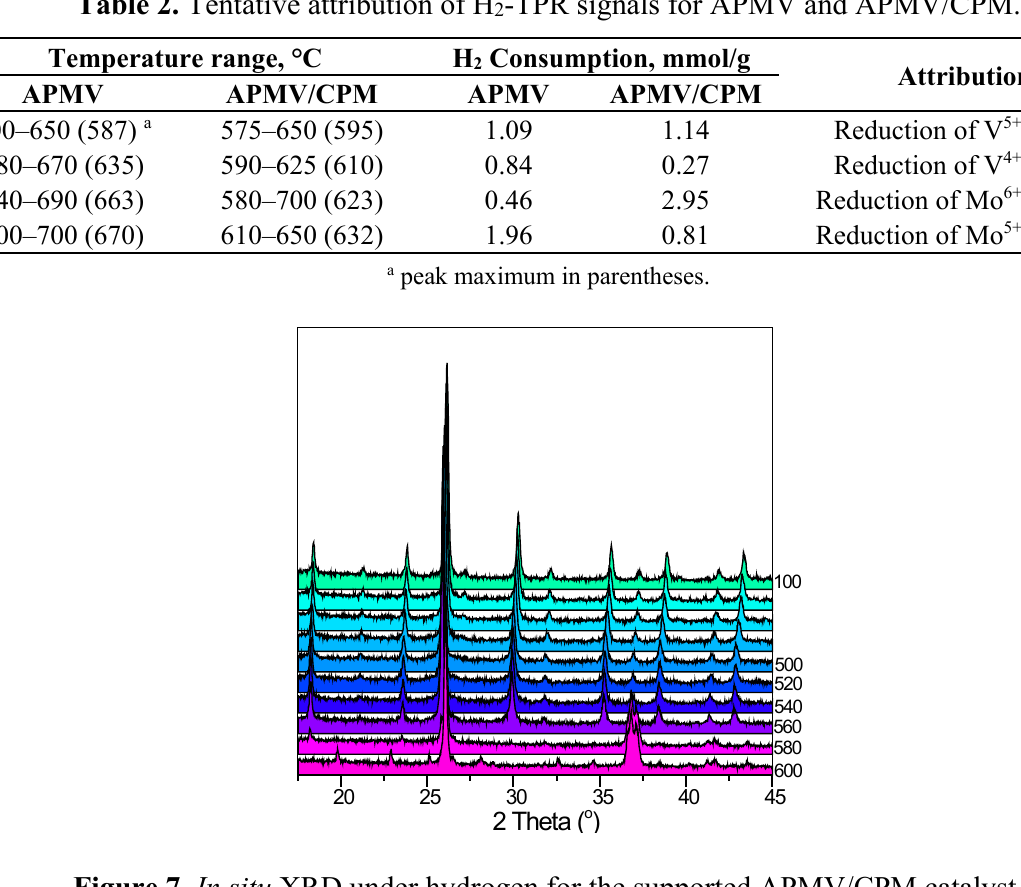
Figure 7. In situ XRD under hydrogen for the supported APMV/CPM